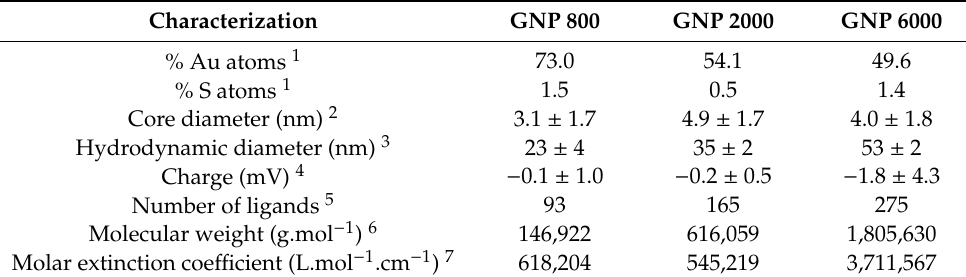
Table 1. Characterization of the three types of ultrastable